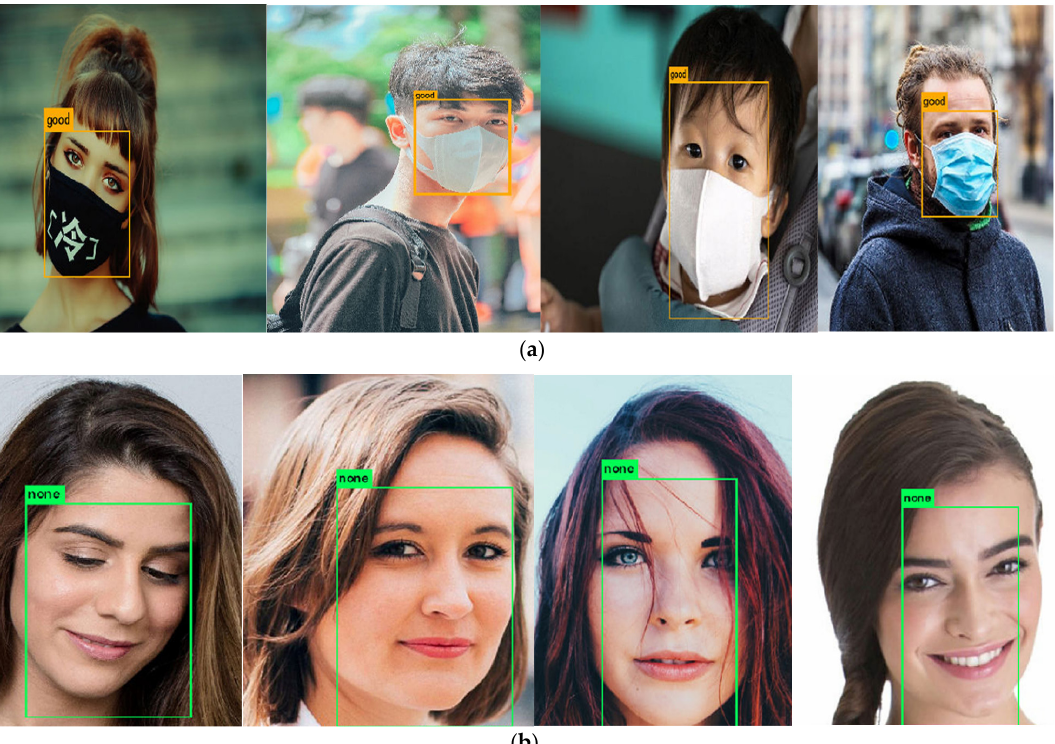
Figure 10. Recognition results of COVID Face Mask Detection Dataset with Yolo V4 CSP. ( a ) Class Good; ( b ) Class None. Source of the human faces: The COVID Face Mask Detection datasets.